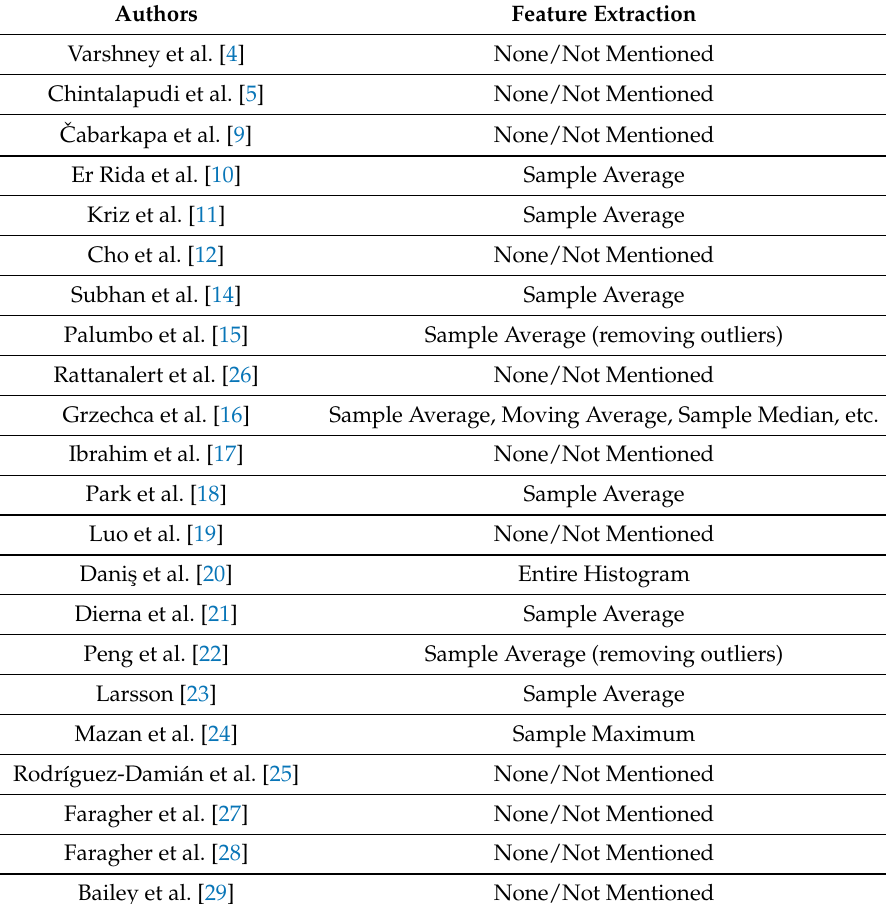
Table 1. Summary table including relevant works on indoor localization based on Bluetooth low-energy (BLE) received signal strength indication (RSSI) and the corresponding feature extraction